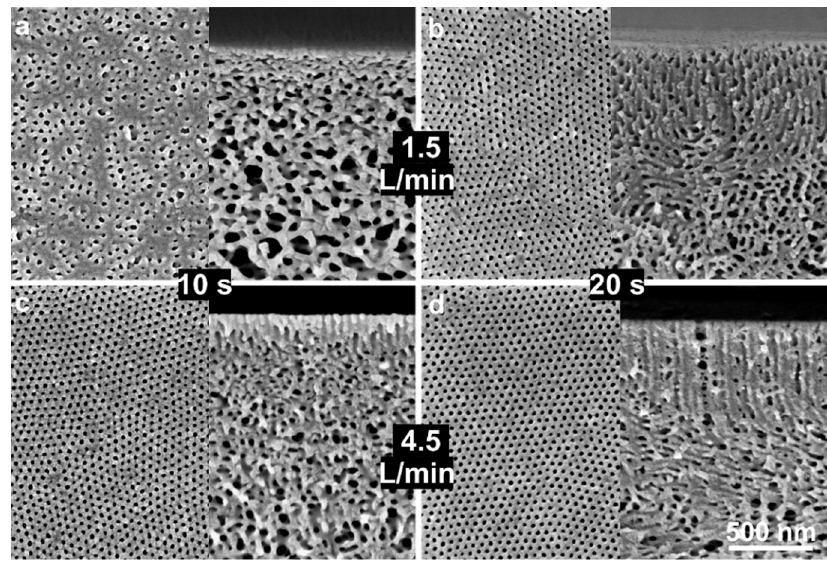
Figure 6. SEM micrographs of the top surfaces and the surfaces of cross-sections of the flat sheets cast using block copolymer solution of 20 wt% PS- b -P4VP 18150 in DMF/THF 1/1 (wt/wt). Casting parameters were Q g of 1.5 (top) and 4.5 L/min (bottom) and for t g of 10 ( a , c ) and 20 s ( b , d ).